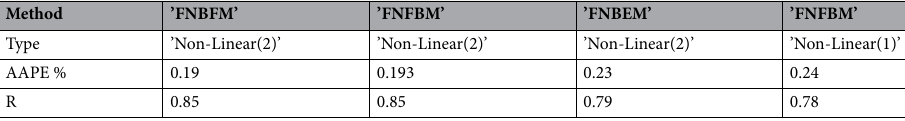
Table 3. Different FN methods and types to optimize the developed model performance with AAPE and R-values for the testing